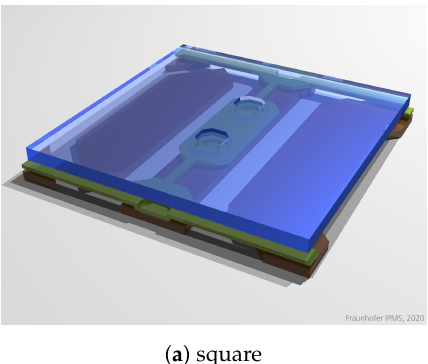
Figure 1. One-axis tilting